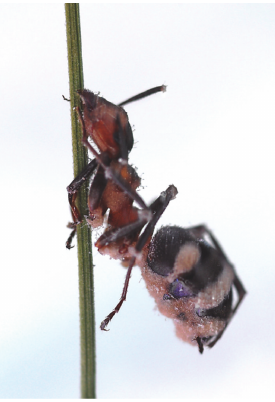
Figure 1: Pandora myrmecophaga having killed a worker Formica rufa , from The Netherlands, showing the characteristic attachment to the distal part of a grass leave caused by the summit disease [after [8]; Photo by H. Niesen; with